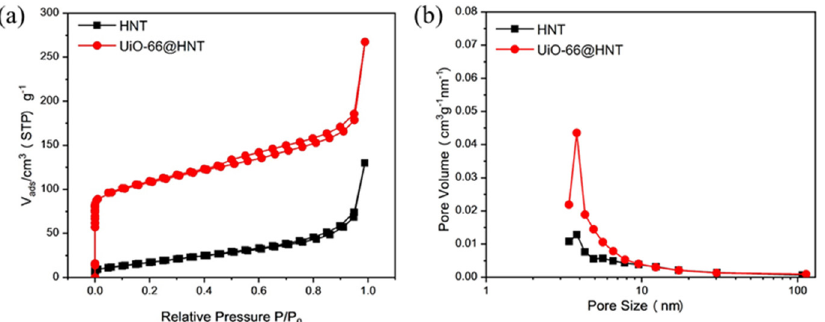
Figure 8. BET data of HNT and UiO-66@HNT: ( a ) Nitrogen adsorption–desorption curve; ( b ) Pore size distribution curve. Table 1. BET data of HNT and UiO-66@HNT. Sample